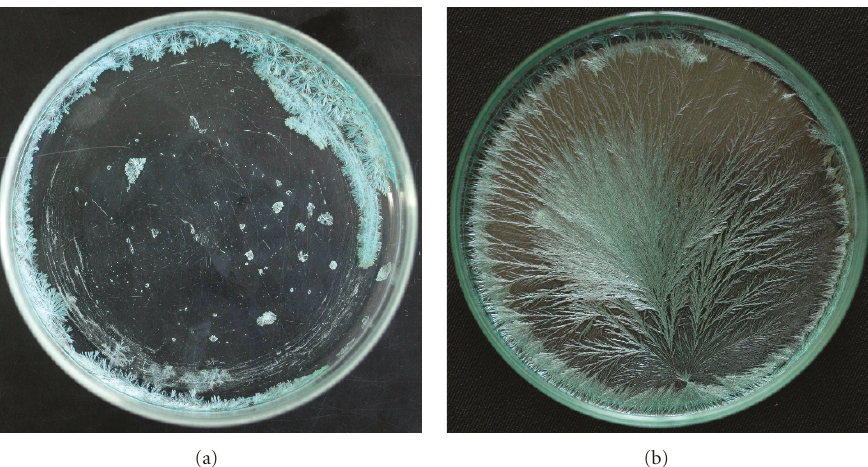
Figure 1: (a) Crystallogram obtained from basis of aqueous CuCl 2 · 2H 2 O (blank).(b) Biocrystallogramobtained from conventionallygrown fresh sweet red pepper.